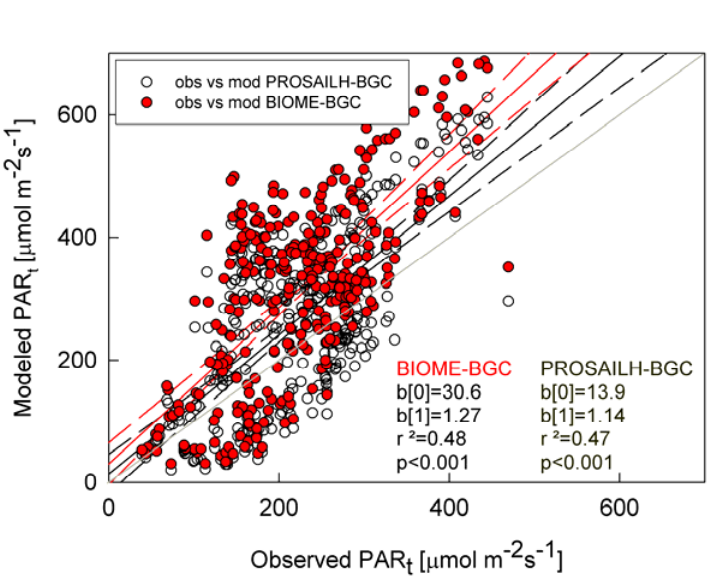
Figure 4. Relationship between modeled and observed PAR modeled with BIOME-BGC while white circles represent data modeled with PROSAIL- BGC. Dashed lines represent the 95% confidence intervals of the linear regression between modeled (with BIOME-BGC in red and PROSAIL-BGC in black) and observed data. PAR t Grey line is the 1:1 line. b[0] is the intercept, b[1] is the slope and p is the significance of the linear regression